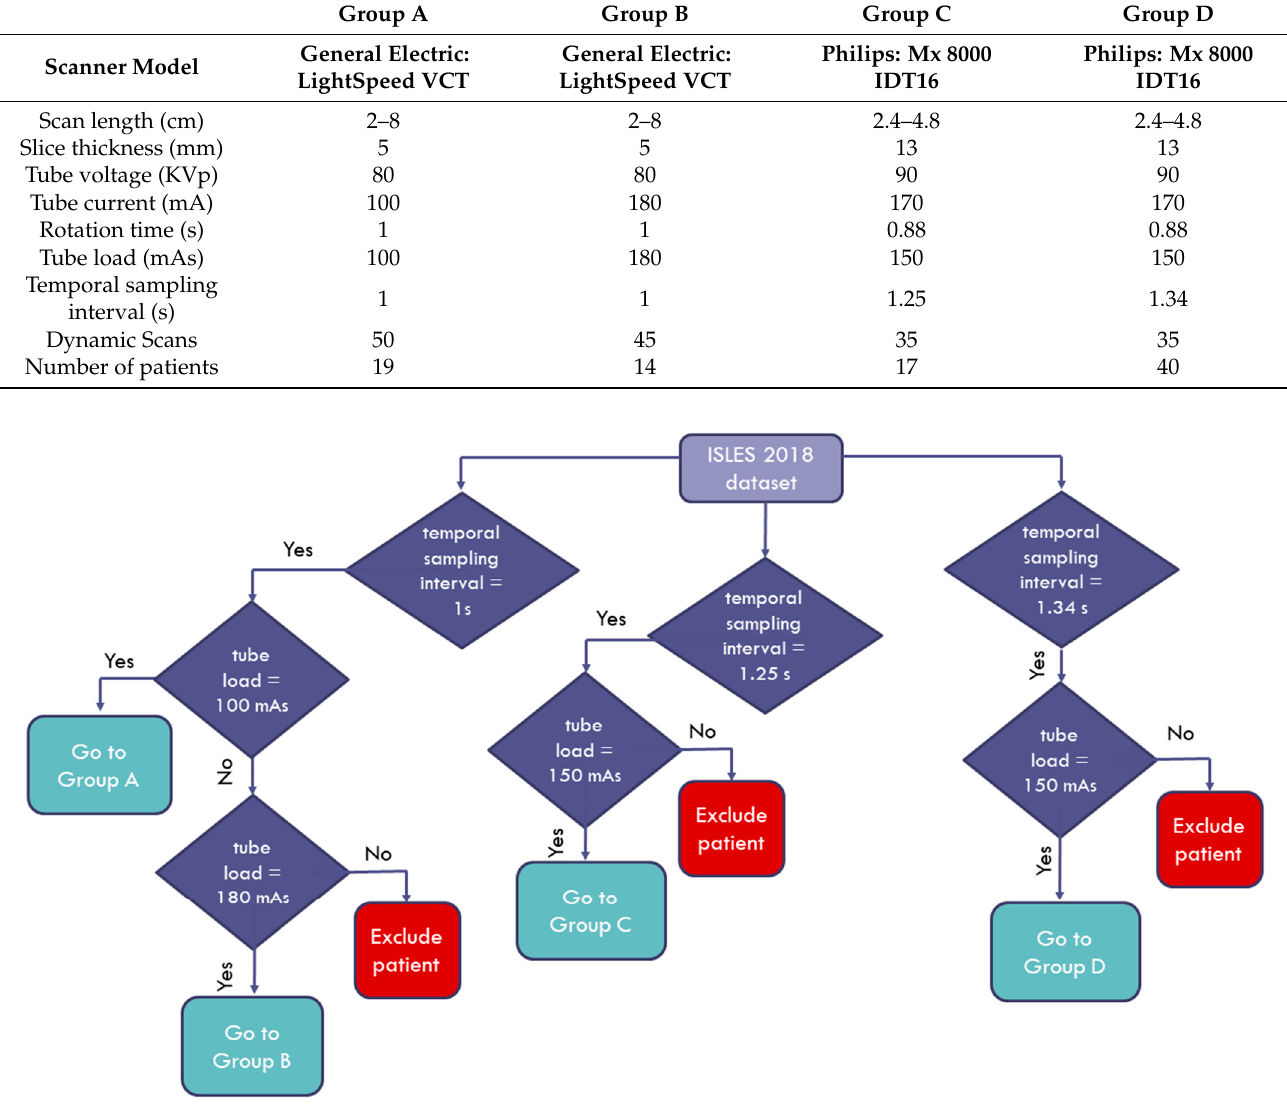
Table 1. Patient groups and imaging parameters for each CT scanner.